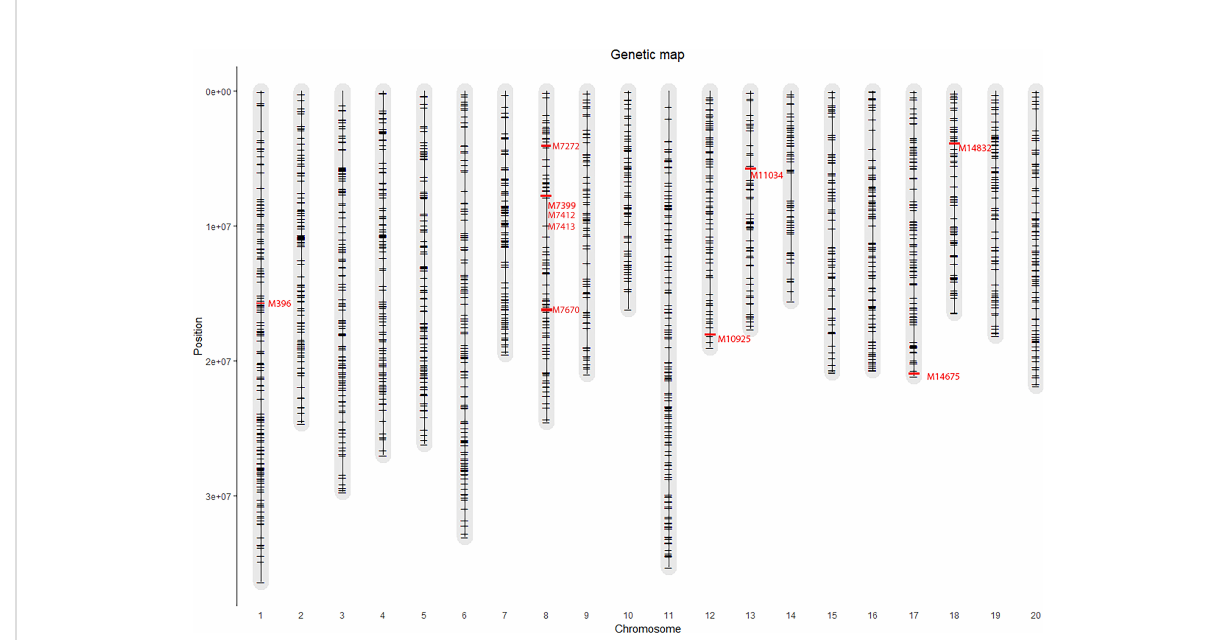
FIGURE 2 Markers distribution on the 20 chromosomes of L. angustifolius genome. In red, signi fi cant markers detected in association with agronomic traits using Bonferroni threshold (LOD 5.52, experiment wise error a = 0.05).